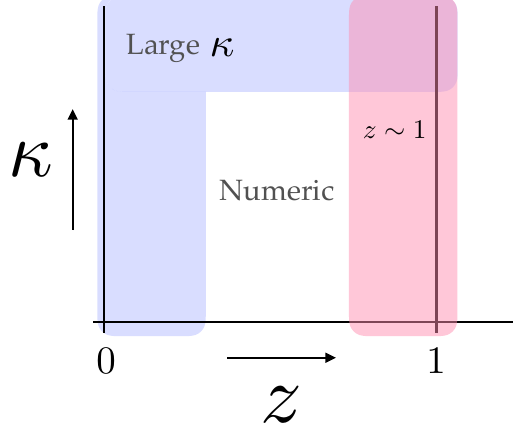
Figure 8 . Shaded regions indicate where the trace Tr( M ) of the monodromy matrix is under analytic control, whereas unshaded region indicate where a numeric analysis of solutions to (2.2) is needed in order to compute Tr( M ). When h L c , the heavy-light approximation (2.19) is valid in (cid:28) the additional region of small (cid:20) , for any z